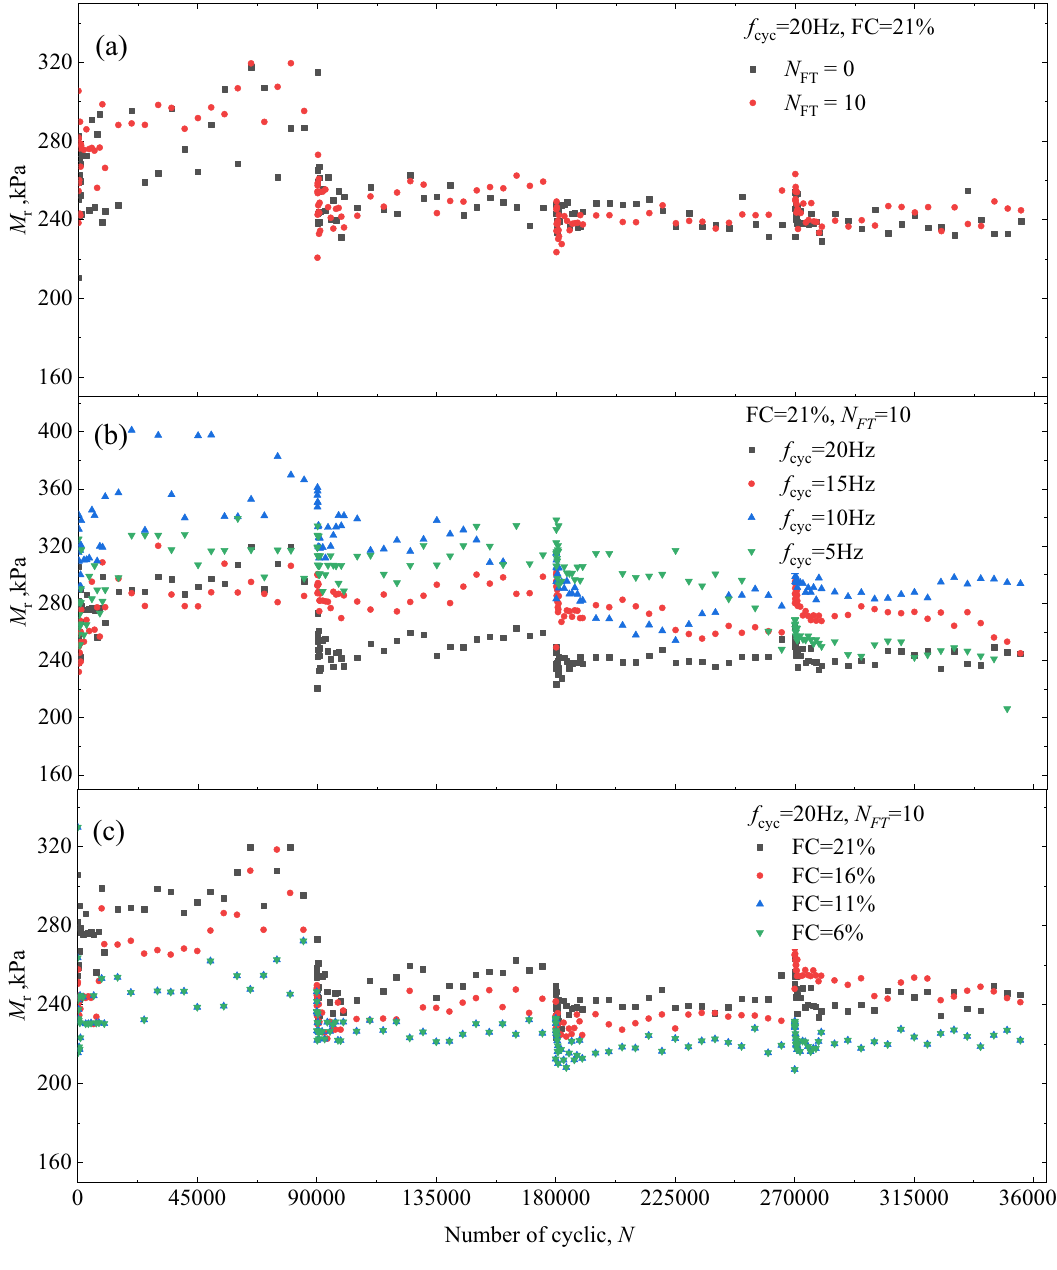
Figure 5. Relationship between M r and number of load applications: ( a ) focusing on the effect of N FT ; ( b ) focusing on f cyc ; ( c ) focusing on FCFreezing–thawing